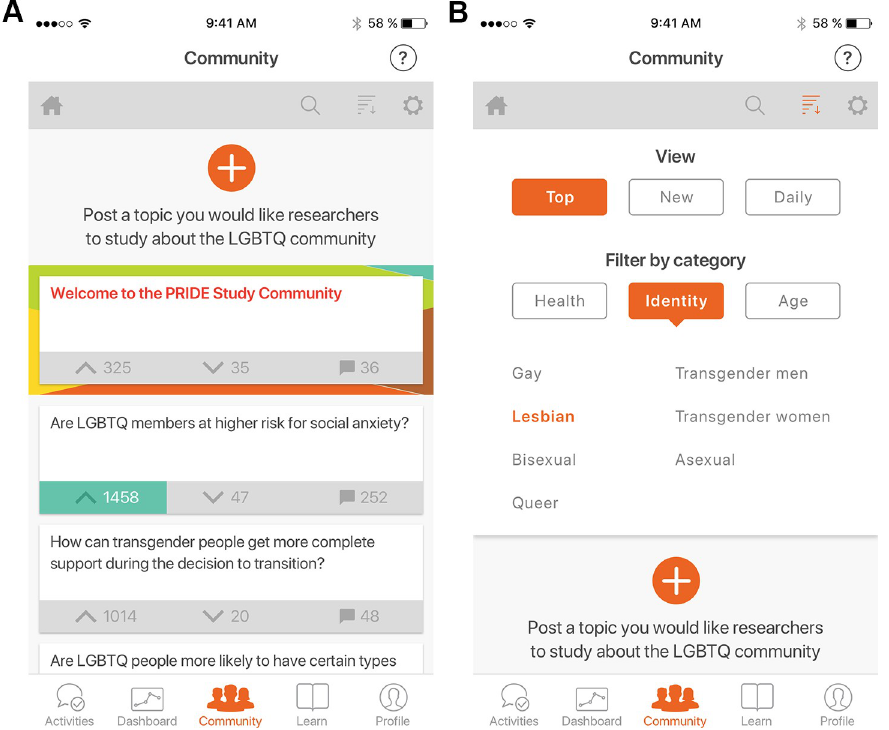
Fig 4. The PRIDE study iPhone app: Community forum. (A) Participants can quickly browse submitted research topics with associated numbers of upvotes, downvotes, and comments. (B) Participants submit a research topic, the reason it is important, and the appropriate